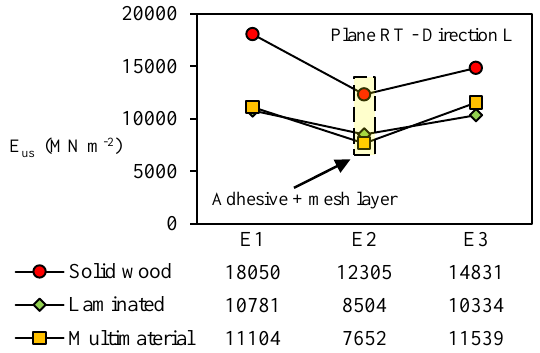
Figure 8 Dynamic Modules in Longitudinal